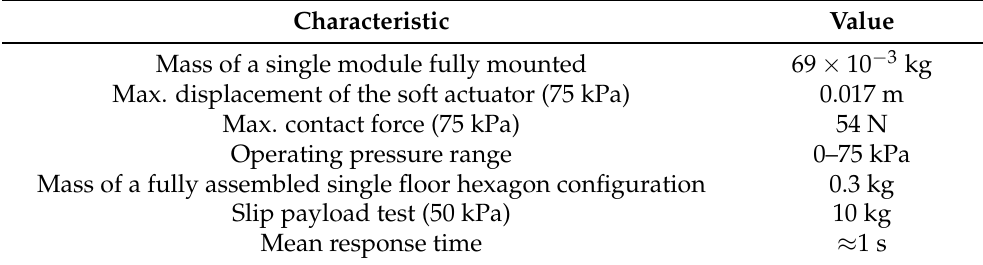
Table 3. Characterization of a soft gripper module and a hexagonal configuration gripper endowed with six soft